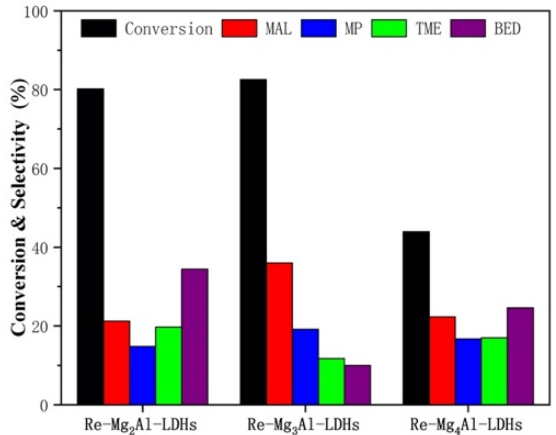
Figure 3. Results of the aldol condensation reaction with re-Mg x Al–LDHs